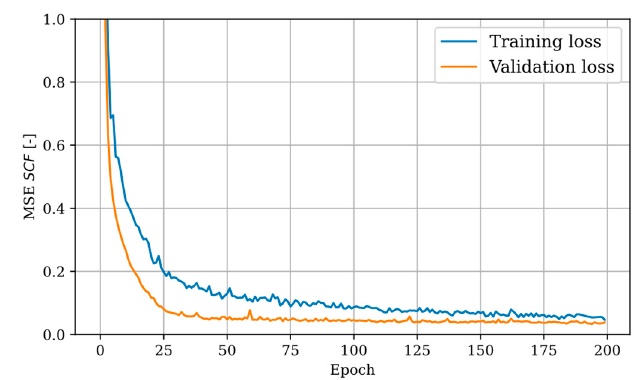
Figure 6. Training history of the DNN.